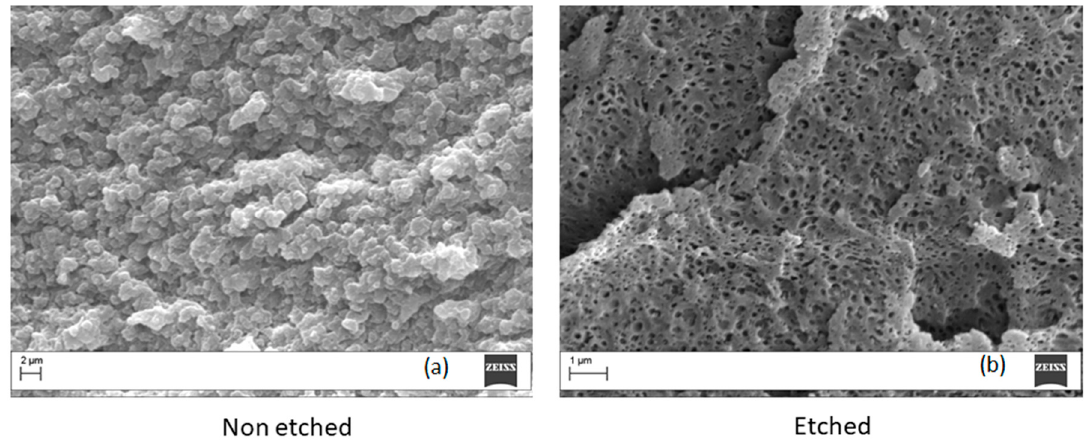
Figure 10. Micrographs of crio-fractured Ultem 9085 samples before ( a ) and after ( b ) chemical etching (magnification 20,000×).